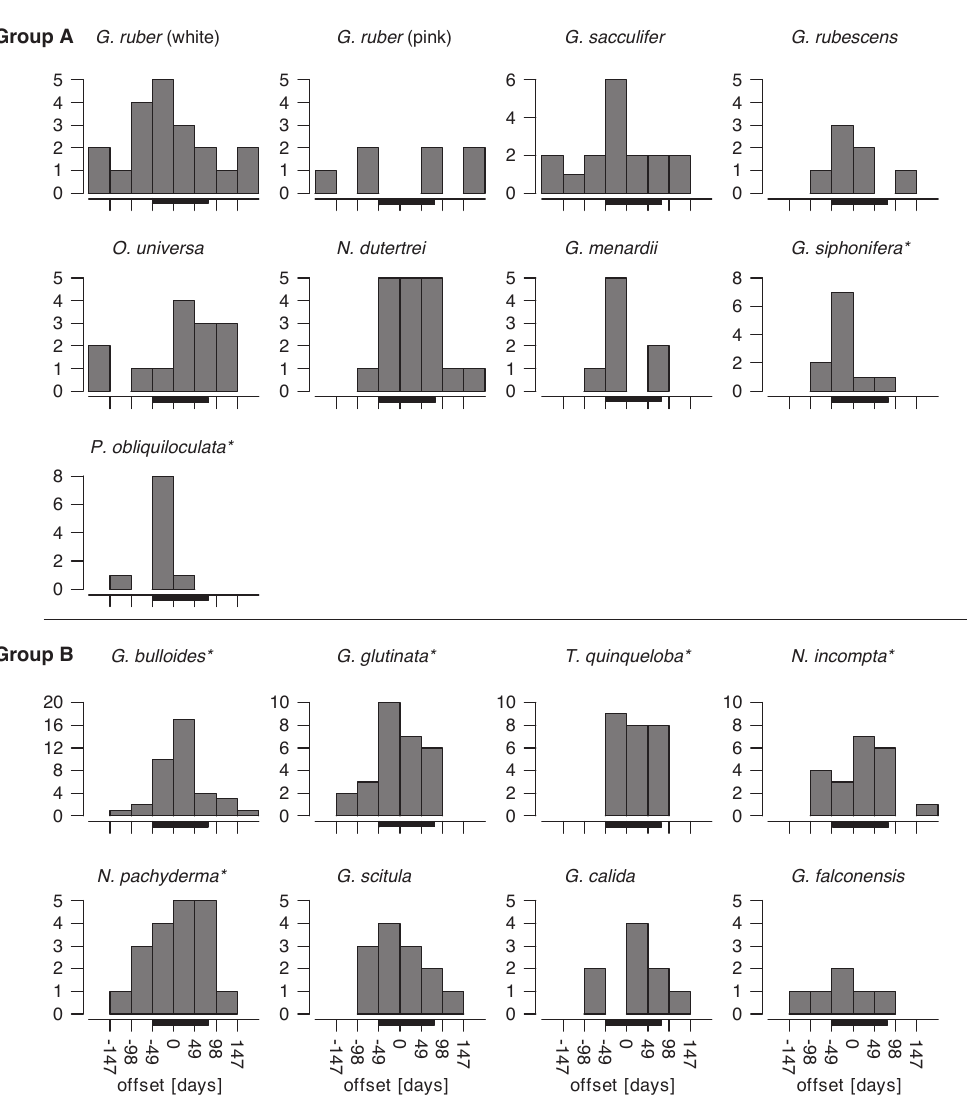
Figure 8. Productivity and peak timing in groups A and B. Histograms of the residual of chlorophyll maxima and peak flux timing. Zero and positive offsets suggest an association between shell flux peaks and productivity. The interval used for the binomial test is highlighted by the black horizontal bar, and species that show a statistically significant association ( p ≤ 0.05) between shell flux peak timing and productivity are marked with an